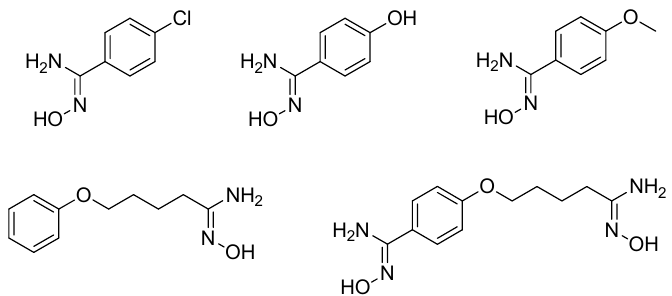
Figure 9. Structures of tested mono- and bis-amidoximes for NO release on rat liver microsomes and human vascular smooth muscle cells.